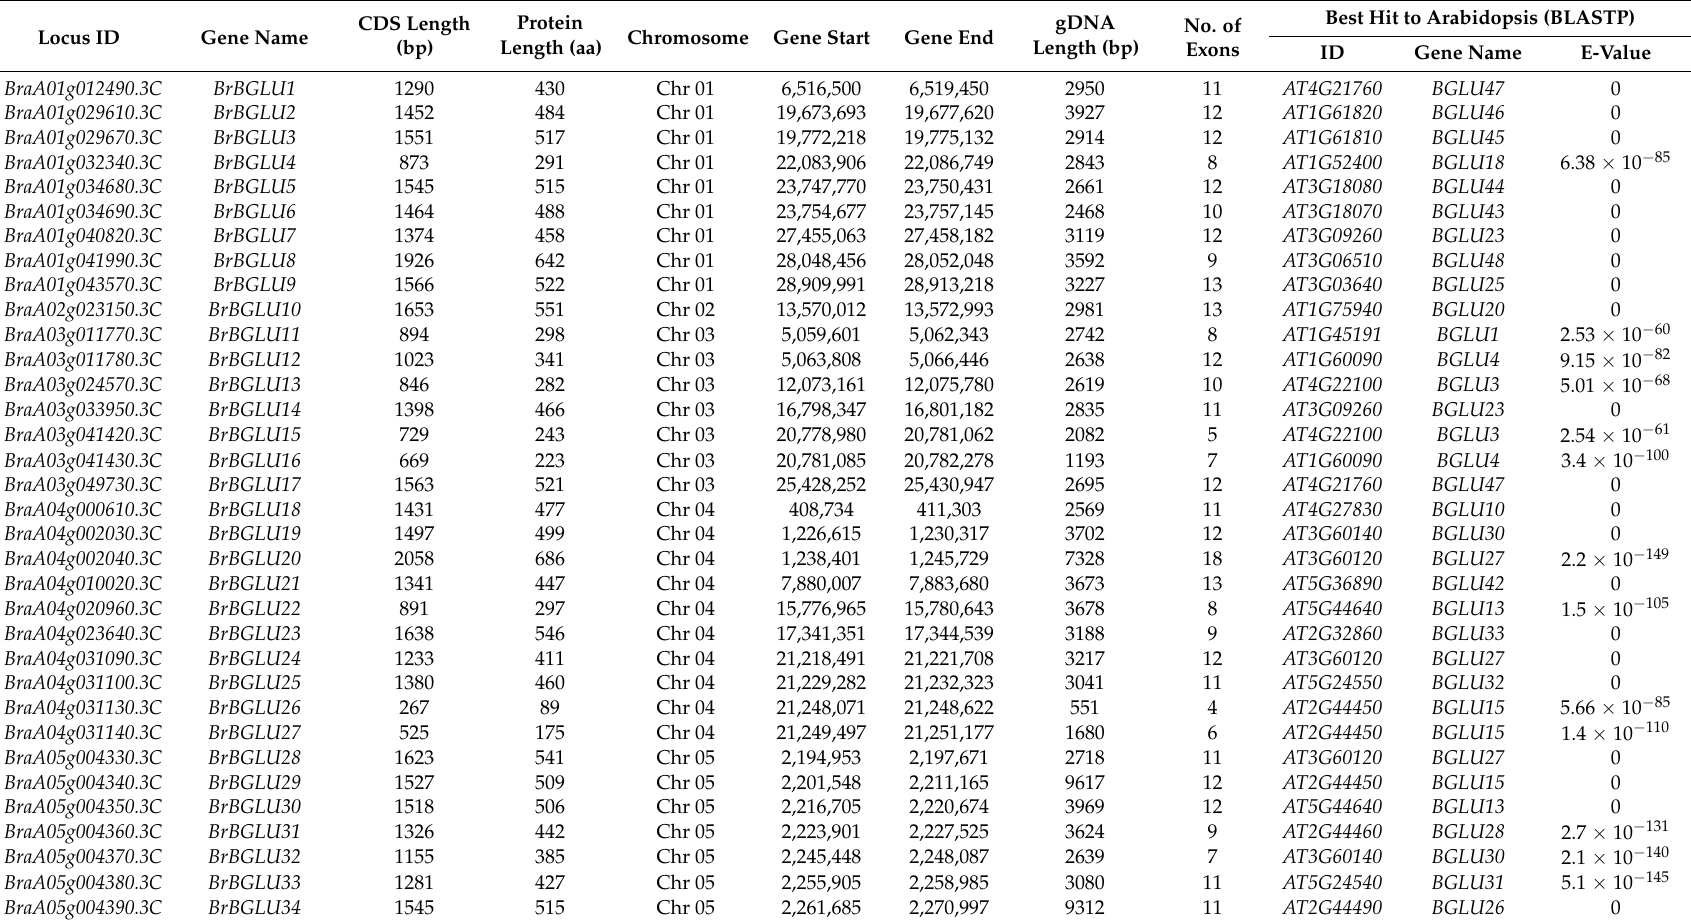
Table 1. Characteristics of the GH1 (Glycoside hydrolase family 1) gene family in Brassica rapa